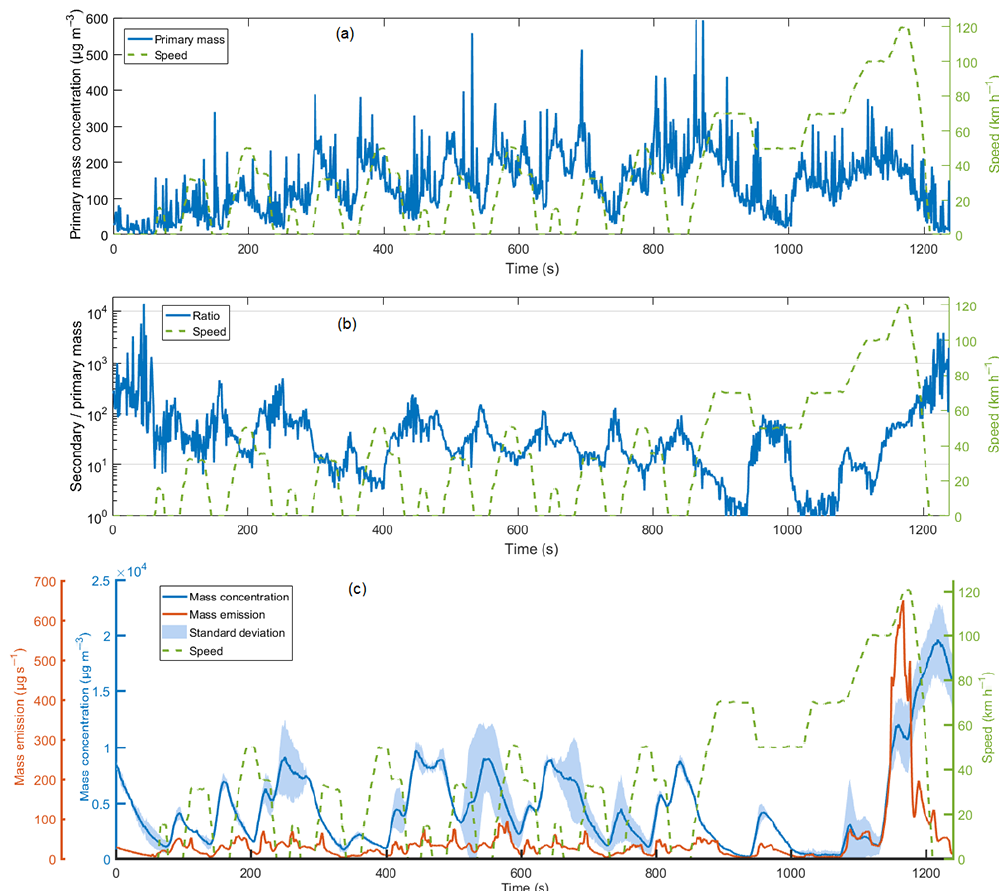
Figure 15. Time series of the vehicle speed and primary mass concentration (a) , speed and the secondary-to-primary mass ratio (b) , speed, the secondary mass concentration (µgm − 3 ) and the secondary mass emission factor (µgs − 1 ) (c) during the NEDC. The emission factor is obtained by multiplying the mass concentration by the total volumetric flow of the